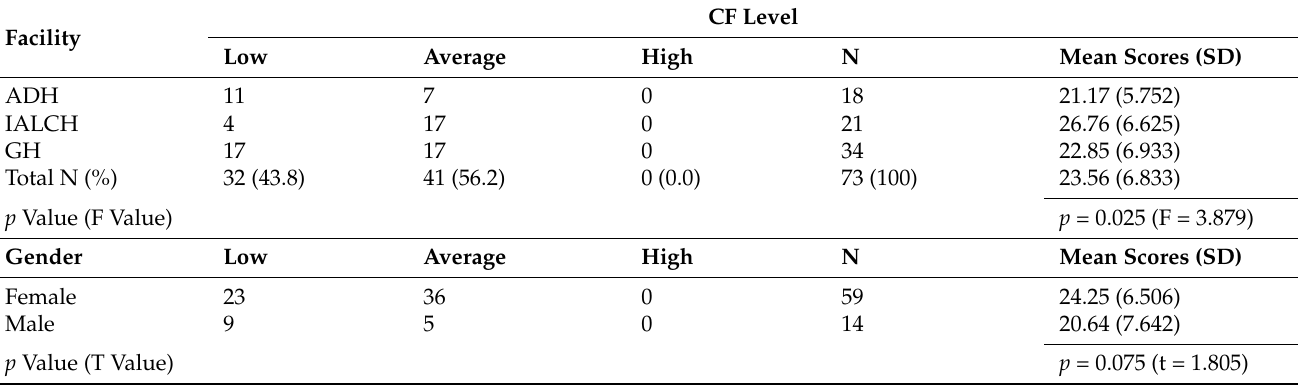
Table 2. Overall Prevalence of Compassion Fatigue and Mean Scores by Healthcare Facility and Gender.